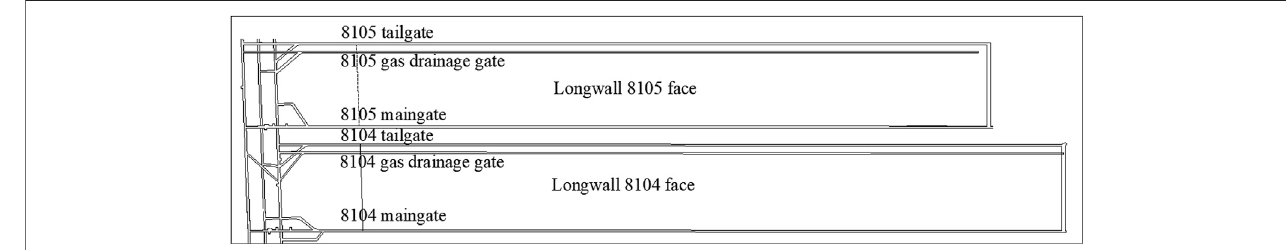
FIGURE 1 | Location map of working faces.